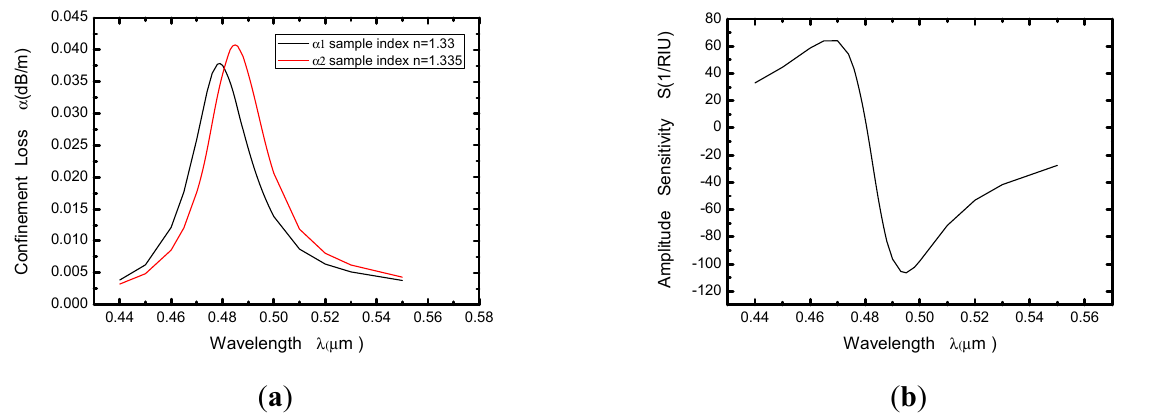
Figure 2. ( a ) Relationship between wavelength and attenuation constant of the fundamental mode of the hollow-core large-mode-area PCF. The black and red curves represent the refractive indices of the samples are 1.33 and 1.335 ( Δλ peak ≈ 6 nm), respectively; ( b ) Intensity detection sensitivity